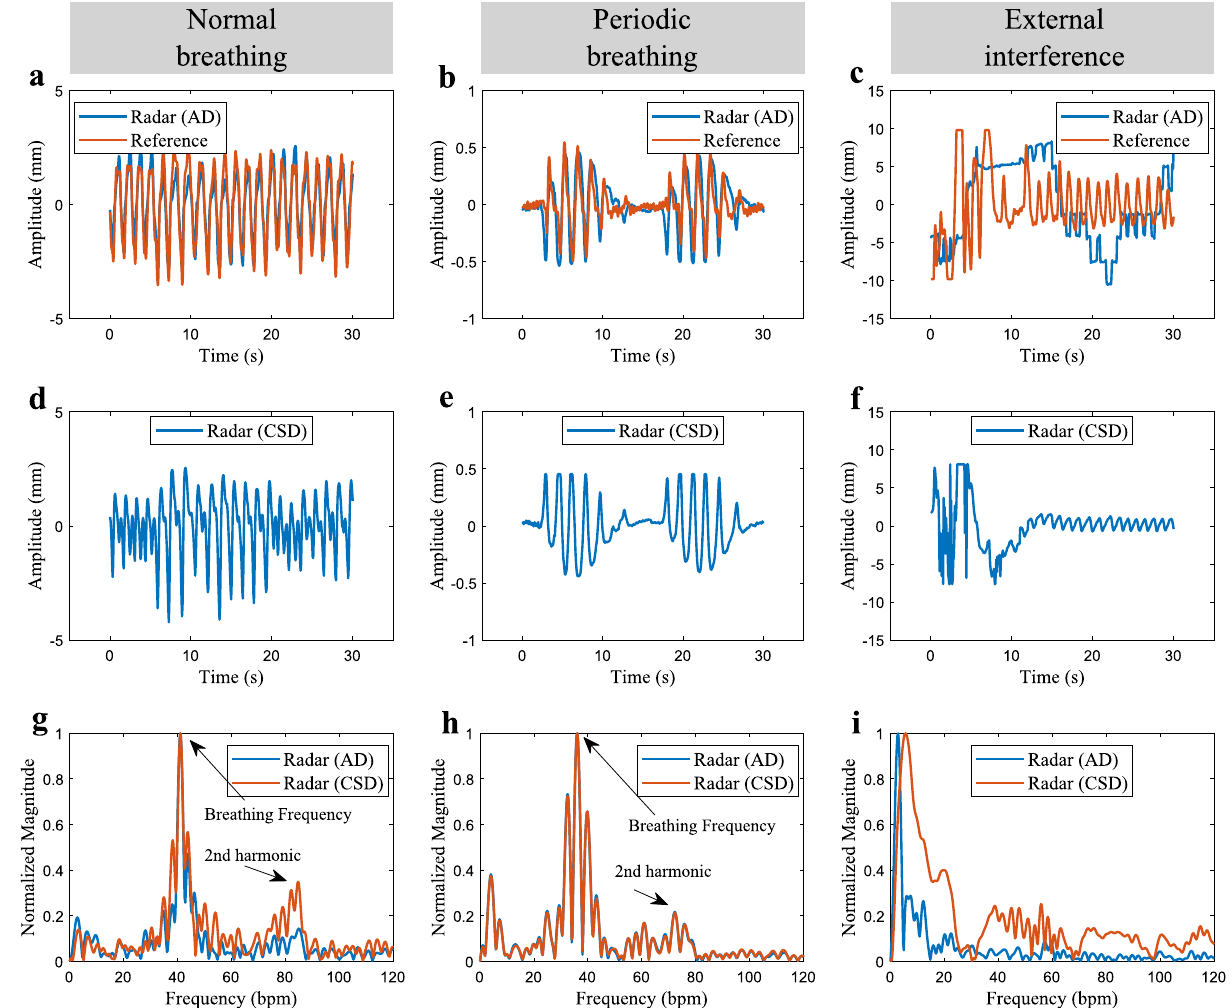
Figure 3. Recovered chest wall motion with different breathing patterns. ( a ) Normal breathing pattern, under good conditions (no interference). ( b ) Periodic (Cheyne-Stokes) breathing pattern. ( c ) Normal breathing pattern corrupted by external interference and ADC saturation. ( d–f ) Approximation using the CSD. ( g–i ) Spectrum comparing AD and